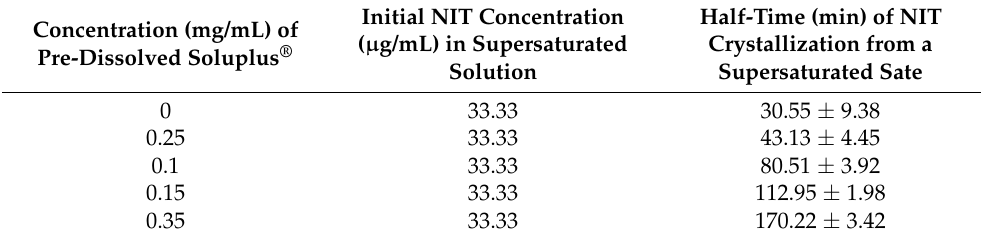
Concentration (mg/mL)